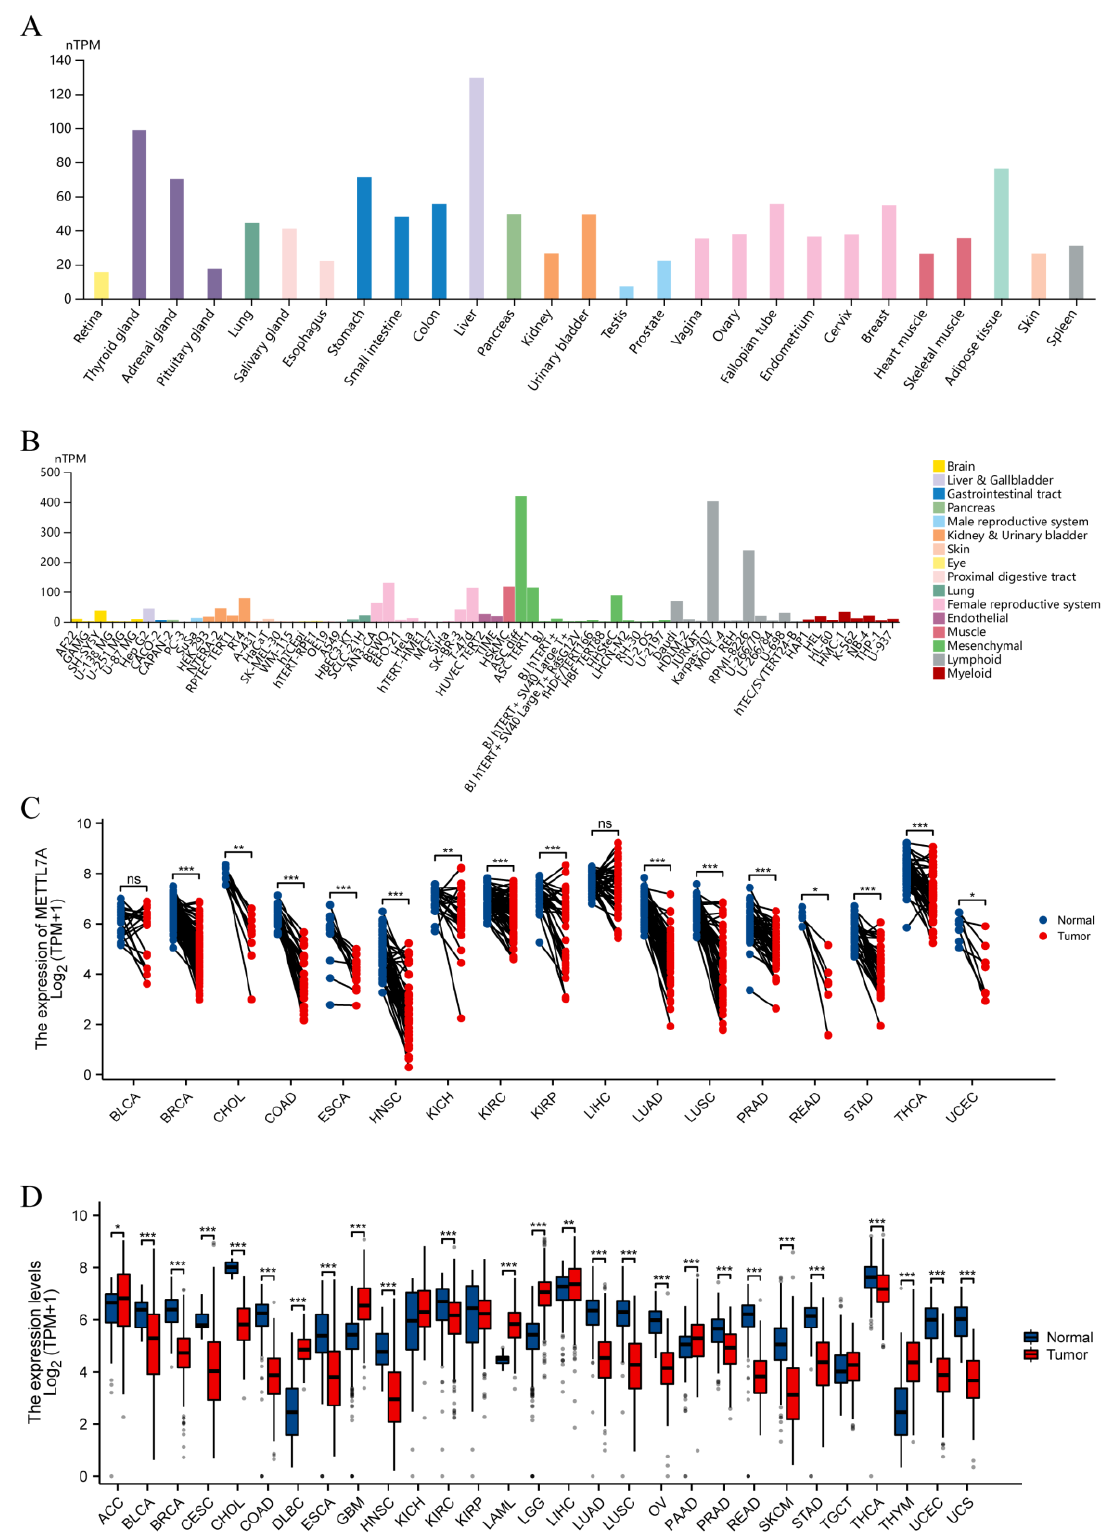
Figure 2. Expression level of METTL7A gene in tumor and normal tissues. ( A ) METTL7A expression in normal tissues; ( B ) METTL7A expression in cell lines; ( C ) METTL7A expression in TCGA tumors and adjacent normal tissues; ( D ) METTL7A expression in TCGA tumors and normal tissues with the data of the GTEx database as controls (grey dot: outlier) ( ns, p ≥ 0.05; *, p < 0.05; **, p < 0.01; ***, p < 0.001).